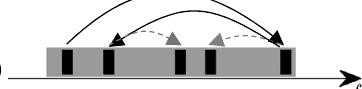
Figure 1. The available power P net for periodic adjustment as a function of the time span τ between adjustment steps.